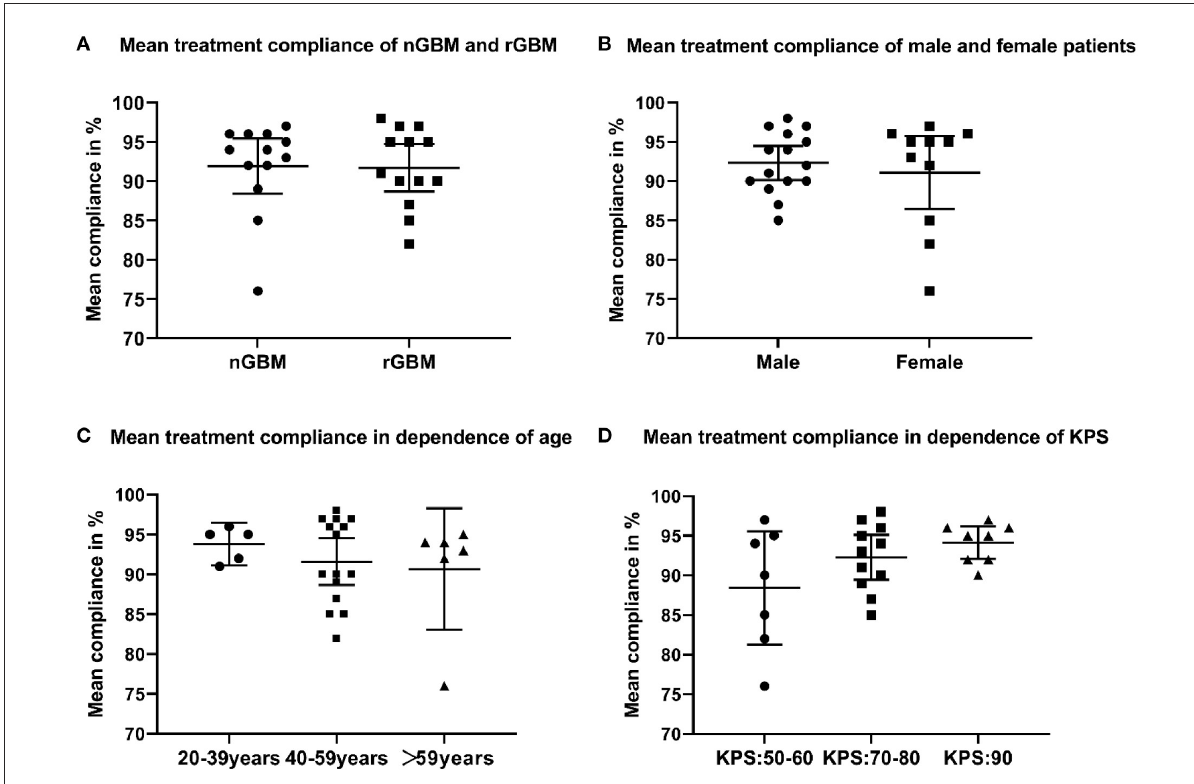
FIGURE4 (A) Mean treatment compliance of newly diagnosed and recurrent glioblastoma (GBM); (B) mean treatment compliance of male and female patients who received TTFields; (C) mean treatment compliance in dependence of age; (D) mean treatment compliance in dependence of Karnofsky performance